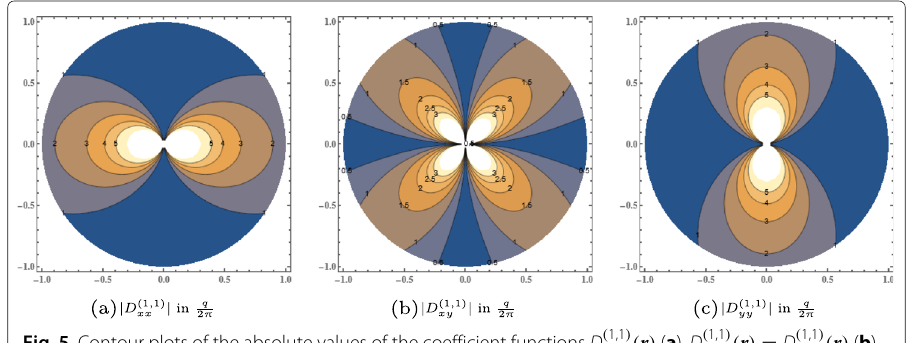
Fig. 5 Contour plots of the absolute values of the coefficient functions D ( 1,1 ) xx ( r ) ( a ), D ( 1,1 ) xy ( r ) = D ( 1,1 ) yx ( r ) ( b ), and D ( 1,1 ) yy ( r ) ( c ) in a homogeneous distribution of loops with radius R = 1. Contours are labeled by function value. Note that as opposed to the other plots in this section, these plots are restricted to distances r < 1 from the